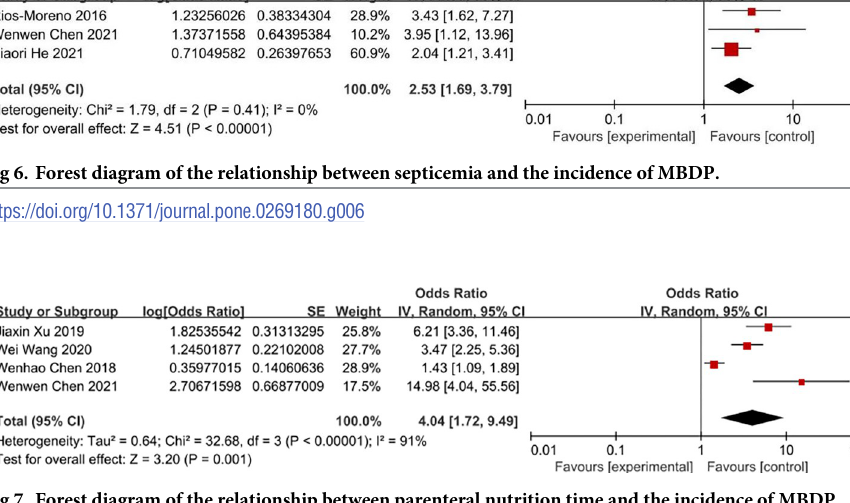
Fig 7. Forest diagram of the relationship between parenteral nutrition time and the incidence of MBDP.